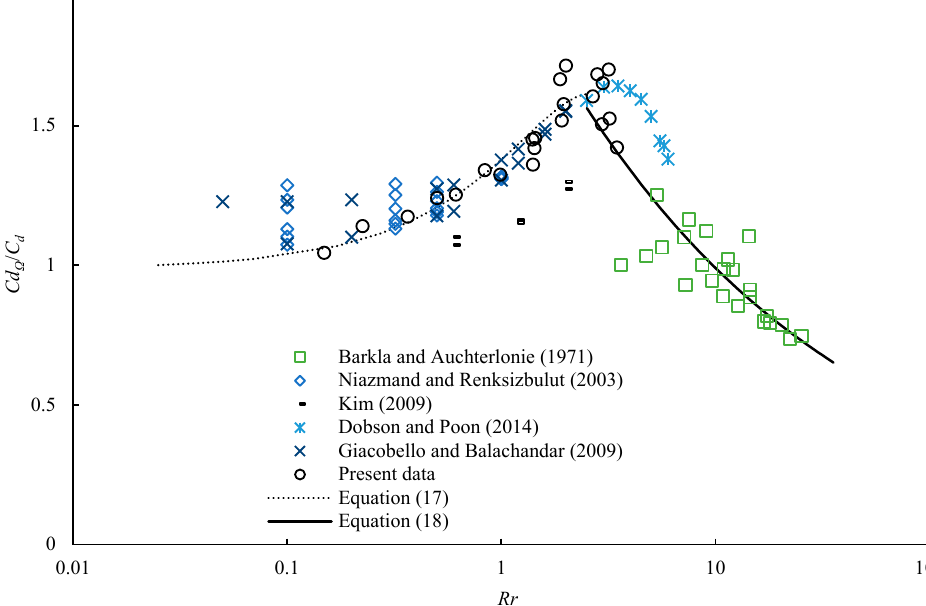
Figure 9. Distribution of the drag coefficient against the dimensionless angular velocity [4,14,15,33,34].